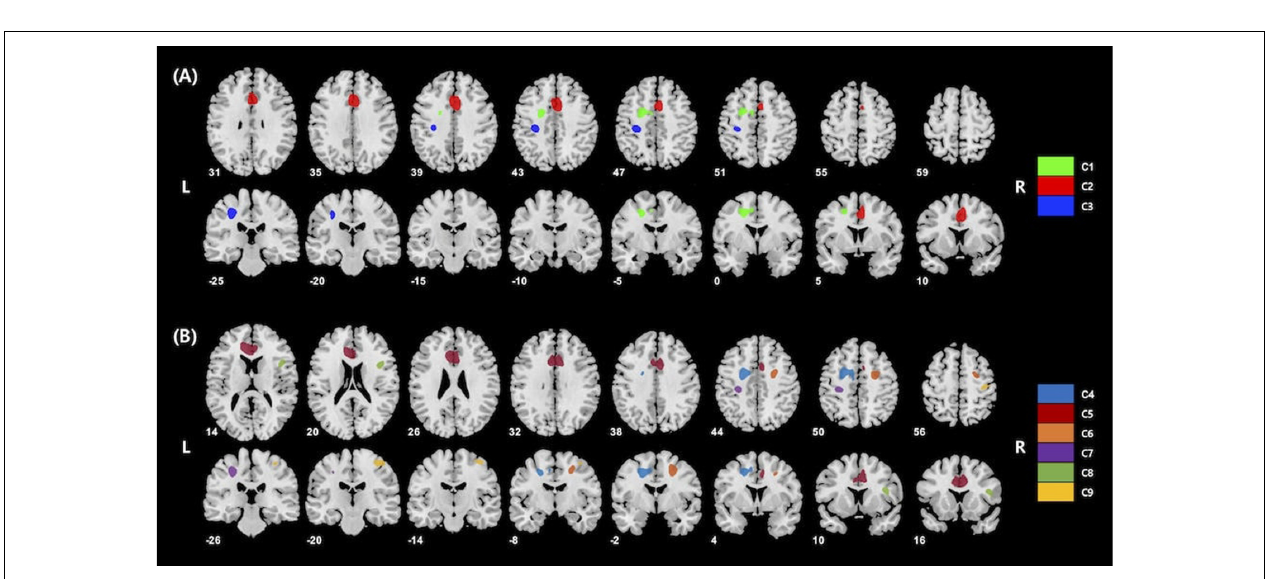
the bilateral MFC, bilateral ACG, bilateral PCG and right inferior